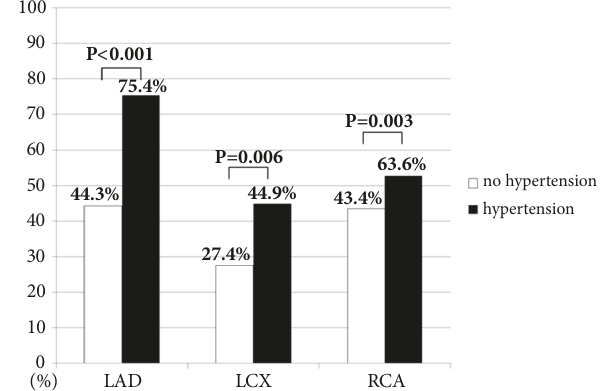
Figure 1: The prevalence of involved vessels in the patients with or without hypertension . Note that the prevalences of LAD-, RCA- , and LCX-related stenosis in patients with hypertension were higher than those in patients without hypertension. Additionally, in patients with hypertension, the LAD-related stenosis was more common compared with RCA- and LCX-related stenosis, p < 0.001. LAD: left anterior descending artery; LCX: circumflex artery; RCA: right coronary artery.